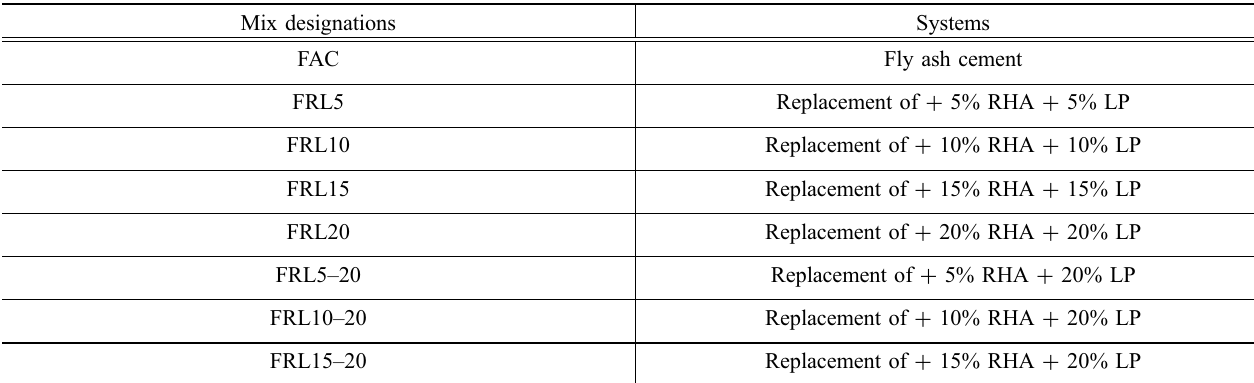
Table 4 Mix systems.